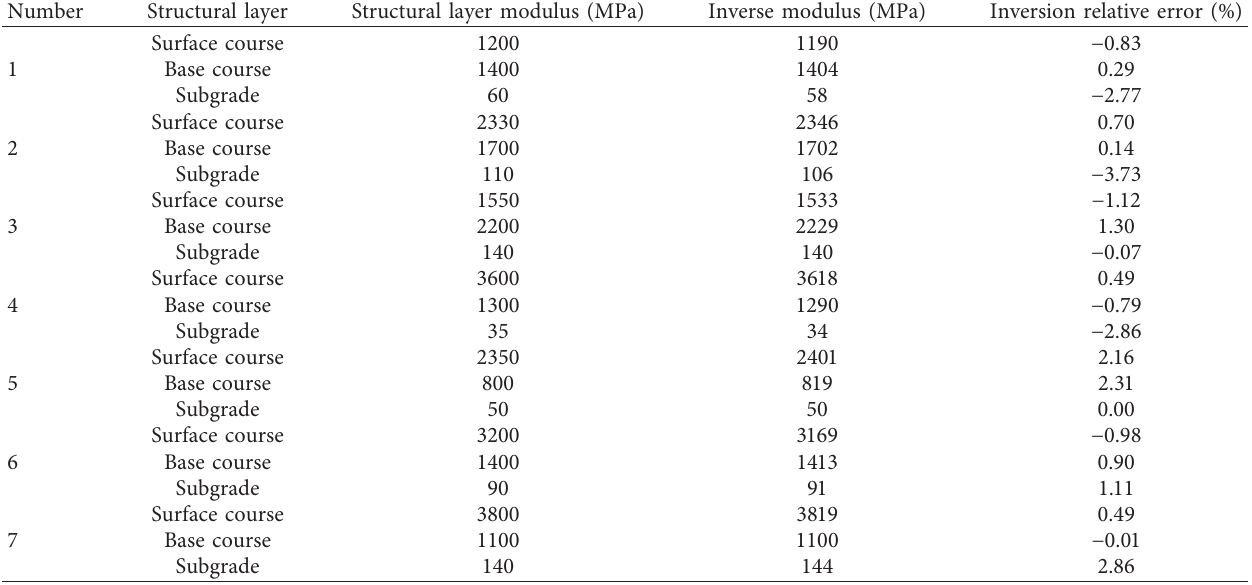
Table 4: Modulus inversion results.